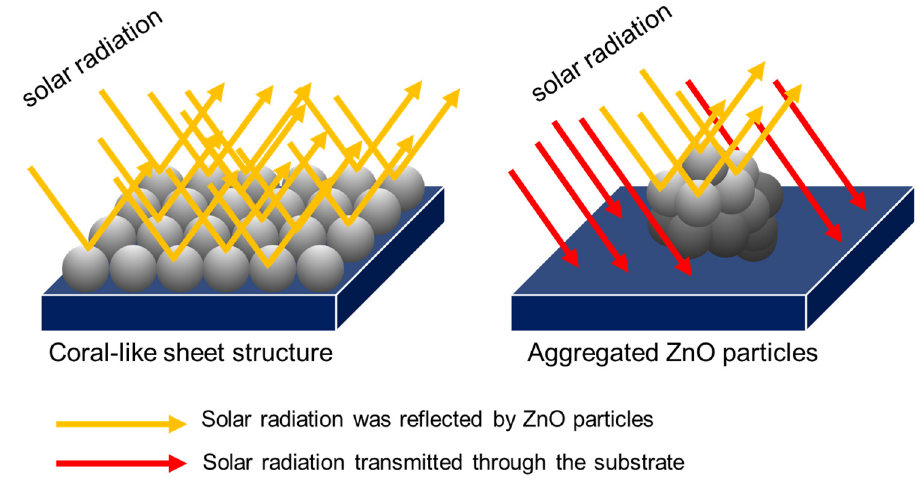
Figure 7. Illustration of solar reflectance at the active site of the coral ‐ sheet structure of ZnO ‐ 80/1 versus the aggregated structure of ZnO ‐ 40/1 and ZnO ‐ 20/1.